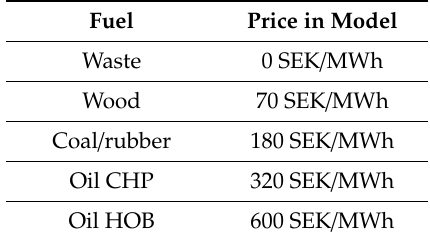
Table 3. Fuel prices in the model. CHP—combined heat and